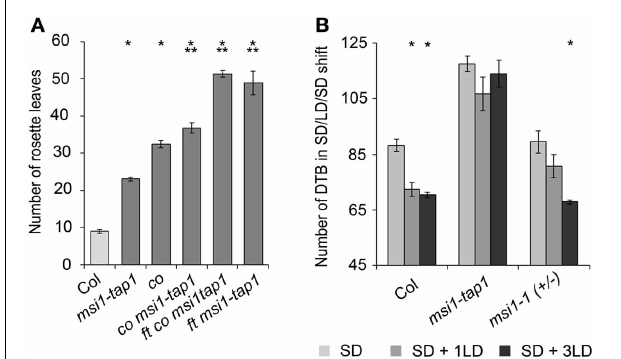
FIGURE 4 | MSI1 is needed for normal sensitivity of the photoperiod. (A) Flowering time of Col, msi1-tap1, co, co msi1-tap1 , co ft msi1-tap1, and ft msi1-tap1 in LD expressed in mean number of RL ± SE ( n ≥ 14). Significance of difference was tested using t -tests. Asterisks denote differences that were significant at p < 0 . 05 to WT ( ∗ ) or co ( ∗∗ ). (B) Flowering time of Col, msi1-tap1 , and heterozygous msi1- 1in SD and after single LD treatments. Plants were grown continuously in SD (light gray bars) or exposed to 1 or 3 LD (16h light/8h dark; dark gray and black columns, respectively) at 45 DAG. LD treatments were performed by extension of the light period and shortening of the following dark period. Flowering time is expressed in DTB ± SE ( n ≥ 14). Asterisks denote significant differences to the corresponding SD-only control ( t -test, p < 0 .